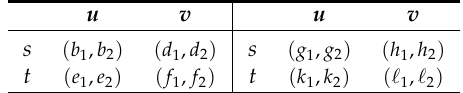
Table 4. Utilities for G 1 (left) and G 2 (right) in Lemma